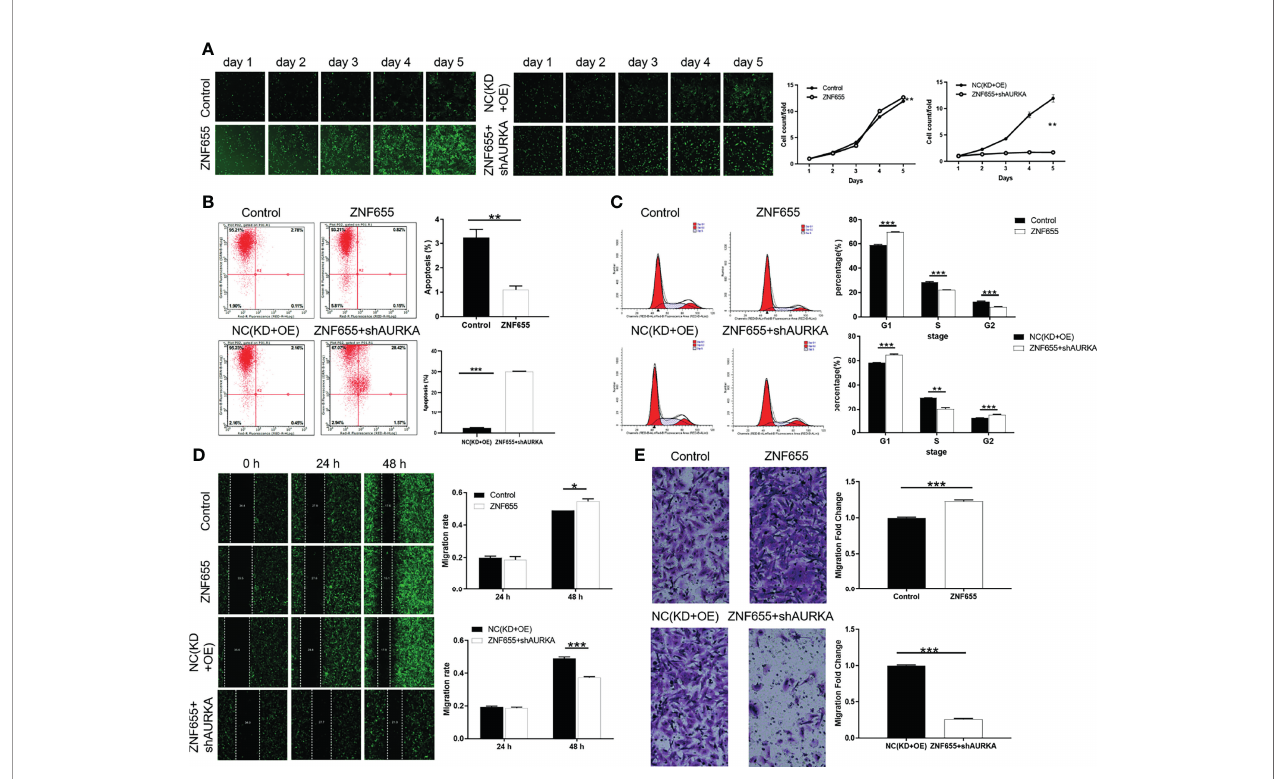
FIGURE 5 | AURKA knockdown alleviates the effects of ZNF655 overexpression on glioma cells. The effects of ZNF655 overexpression or AURKA knockdown on proliferation, apoptosis, cycle, and migration of U251 cells were examined by Celigo cell counting assay (A) , fl ow cytometry (B, C) , wound-healing assay (D) , and Transwell assay (×200 magni fi cation) (E) , respectively. The data were expressed as mean ± SD (n ≥ 3), *p < 0.05, **p < 0.01, ***p <